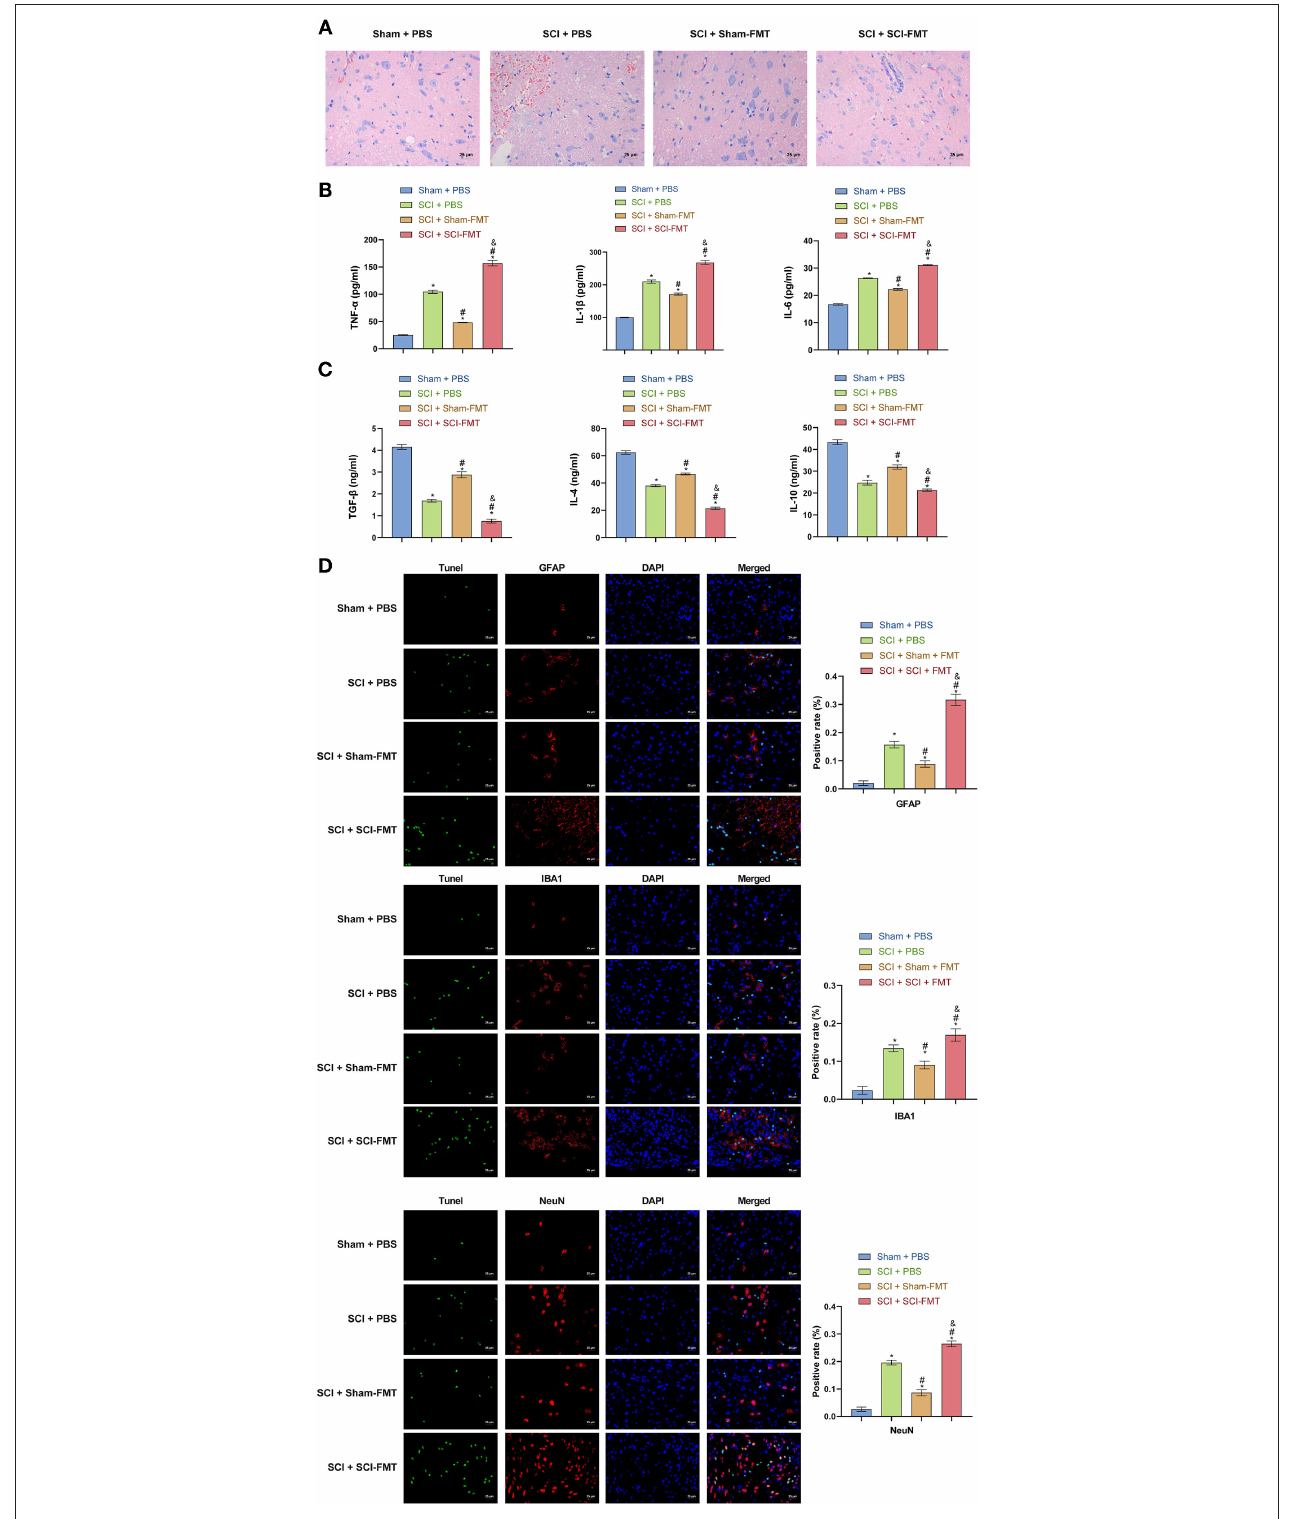
FIGURE 7 | Imbalance of gut microbiota exacerbates SCI. (A) Hematoxylin and eosin staining was used to detect SCI in each group. (B, C) ELISA was used to observe the content of inflammatory factors in the serum of mice in each group. (D) TUNEL assay and immunofluorescence detection of spinal cord cell apoptosis in each group of mice (Scale bar = 25 µ m). *, P < 0.05 compared with the Sham + PBS group. #, P < 0.05 compared with the SCI + PBS group. &, P < 0.05 compared with the SCI + Sham-FMT group. Multiple comparisons in groups were evaluated by one-way analysis of variance n = 5.